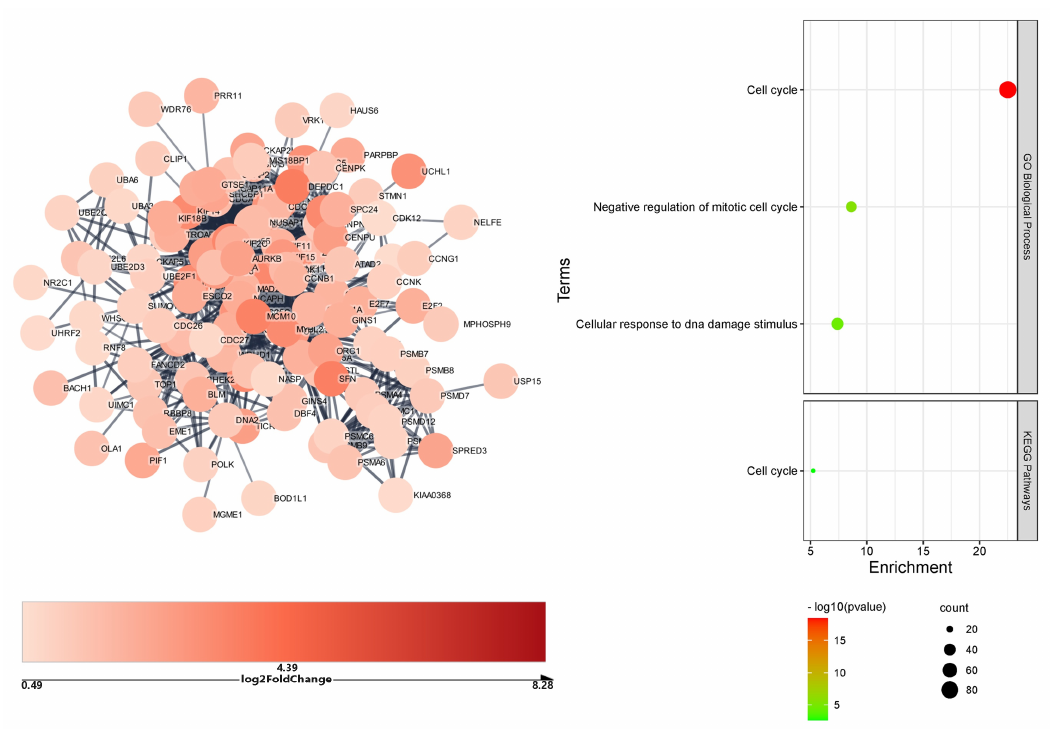
Figure 3. Cluster and functional enrichment analysis of COVID − 19 lung upregulated DEGs targeted by downregulated microRNAs. STRING interaction confidence score > 0.7; Markov clustering inflation value = 4; STRING Enrichment FDR < 0.05; redundancy score = 0.5. In the lymph nodes, the 369 downregulated DEGs impacted by the upregulated microRNAs formed a network of 369 nodes and 180 edges. After Markov clustering, the largest cluster identified comprised 16 genes with 33 edges (PPI = 3.6 × 10 − 6 ) (Figure 4), the functional enrichment analysis of which depicted positive regulation of cytokine production (biological process) and primary immunodeficiency (KEGG pathway) as the most impacted by microRNA. The lymph nodes upregulated DEGs potentially targeted by the downregulated microRNAs formed a network with 322 nodes and only 51 edges, which was unsuitable for functional enrichment analysis.